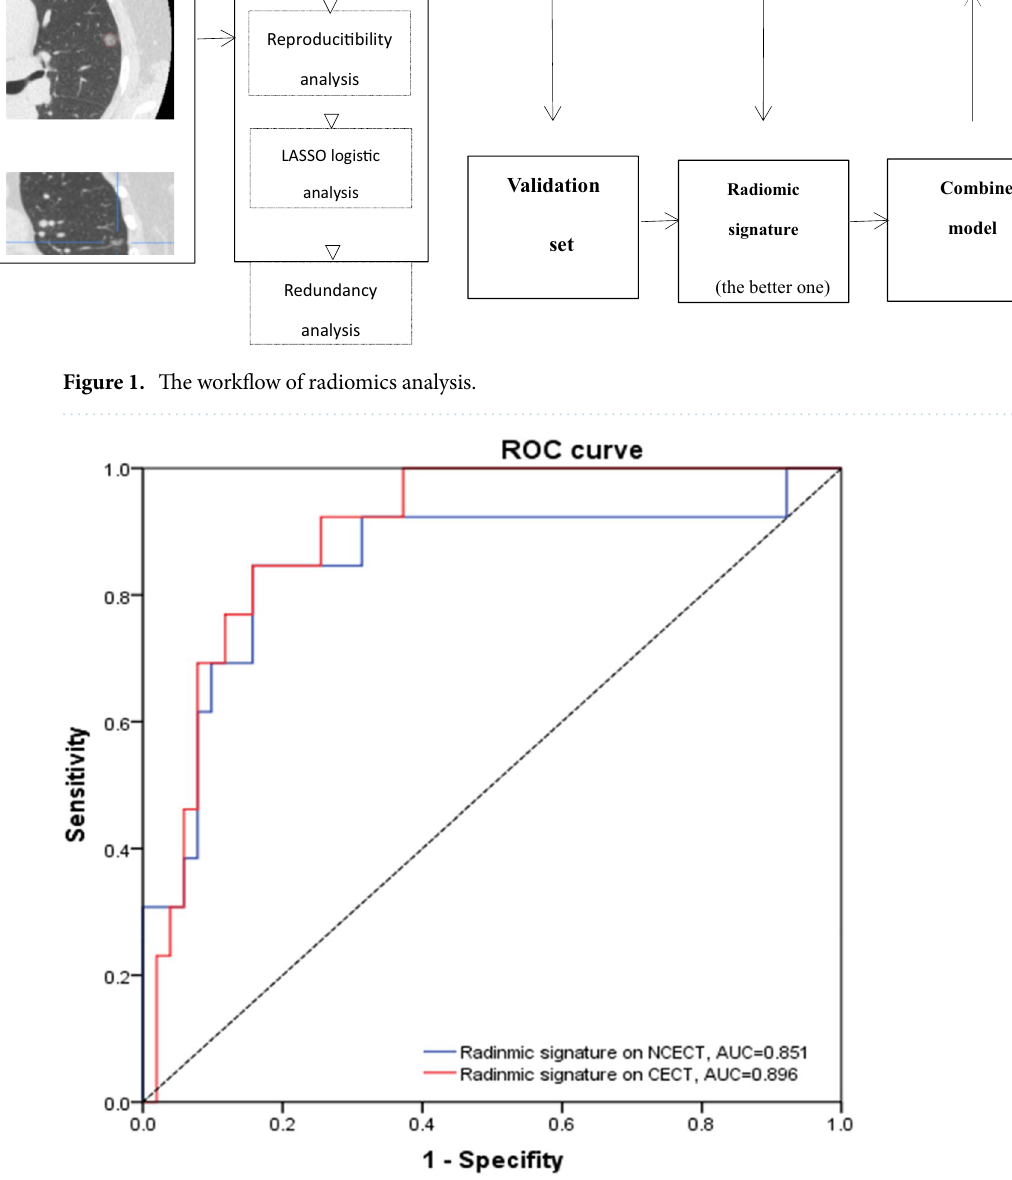
Figure 2. Comparison of ROC curves between radiomics model on CECT (rad line) and radiomics model on NCECT (blue line) in the validation